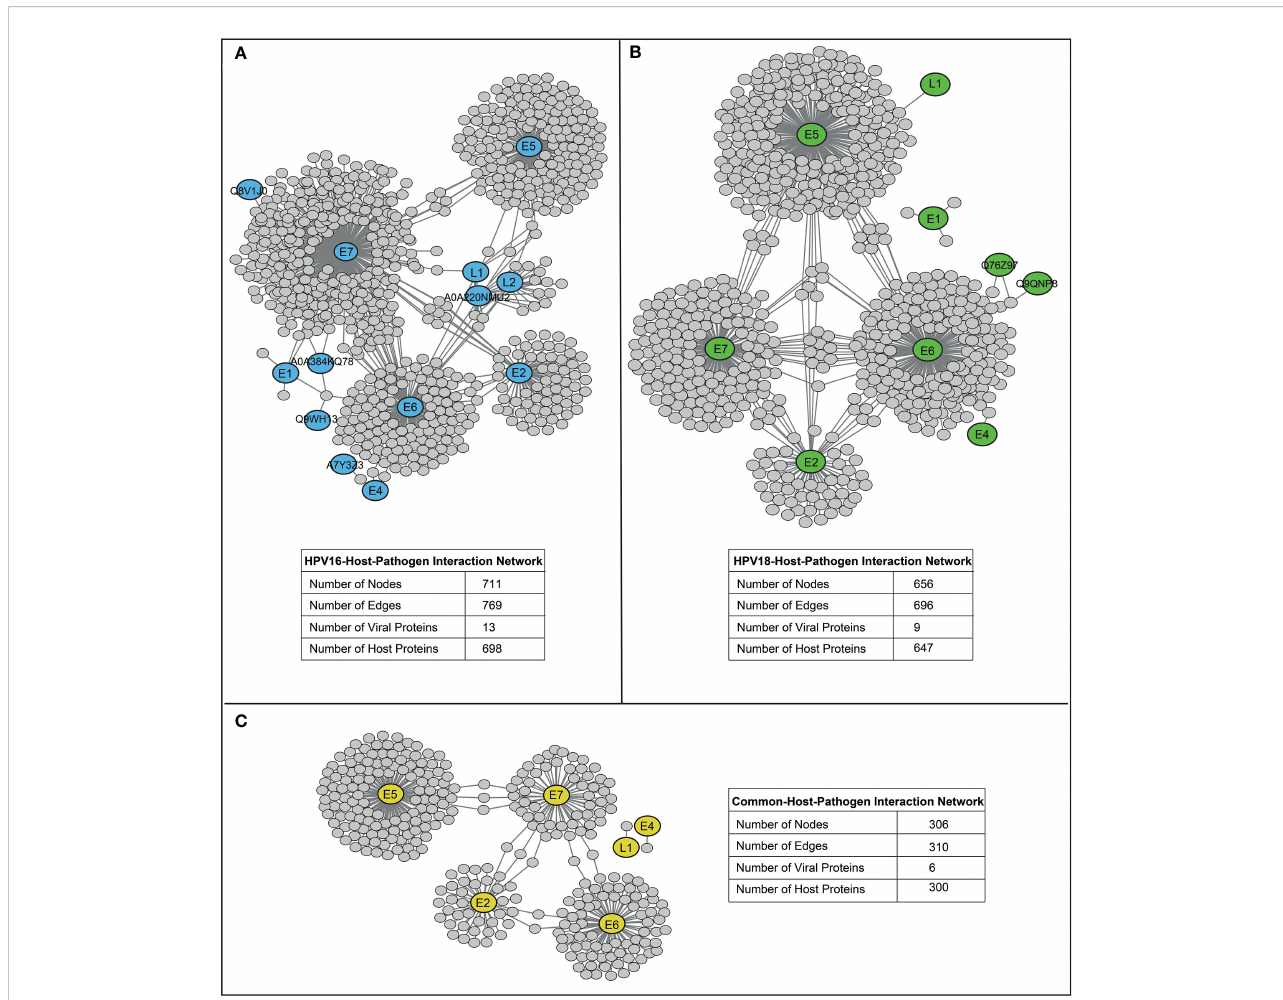
FIGURE 2 The reconstructed host-pathogen-protein interaction networks. (A) The reconstructed host-pathogen-protein interaction network for HPV16. (B) The reconstructed host-pathogen-protein interaction network for HPV18. (C) The host-pathogen-protein interaction network composed of mutual viral and host proteins of HPV16 and HPV18